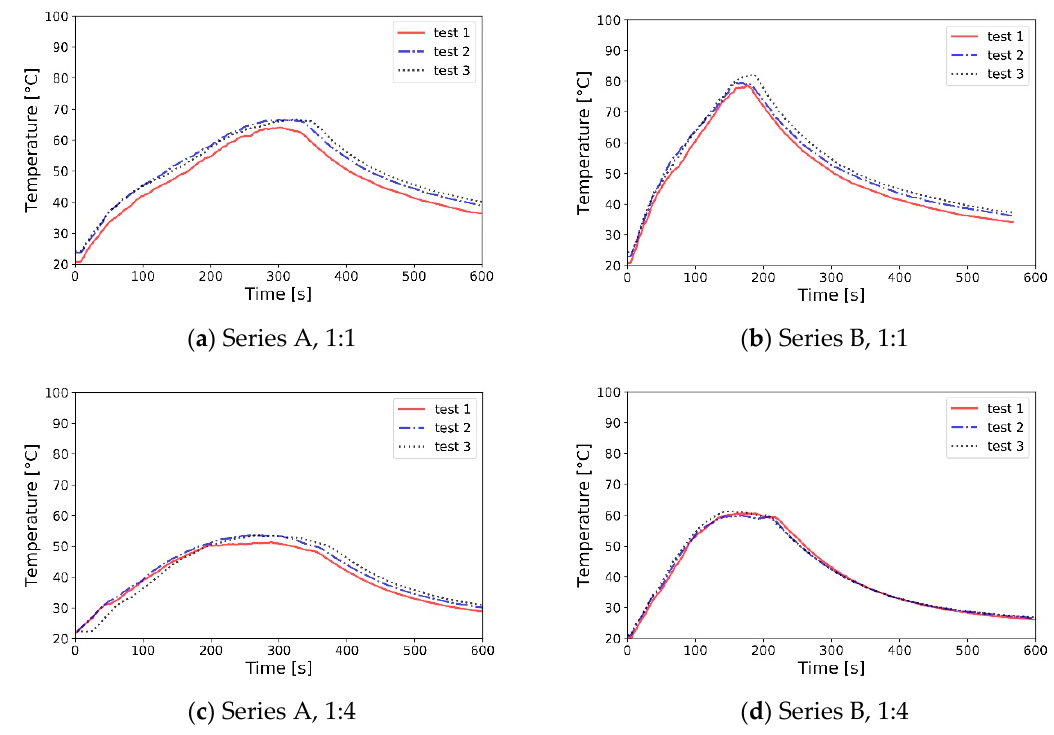
Figure 13. Mean temperature in full- and reduced-scale experiments. Value averaged on four measurements points underneath the ceiling.